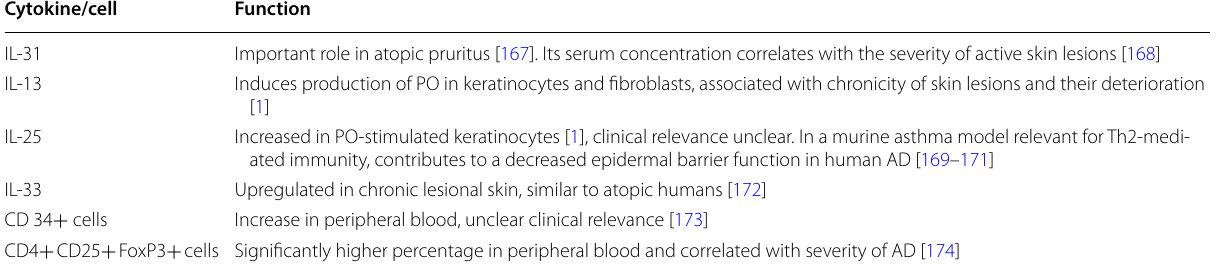
Table 2 Recent findings on T cells and cytokines in canine atopic dermatitis